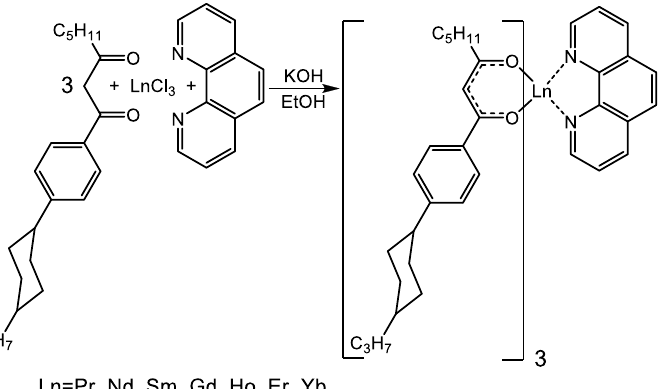
Figure 1. Synthesis of tris( β -diketonate) lanthanide(III) complexes with 1,10-phenanthroline. The solutions of these complexes in toluene (1 × 10 –3 mol/L) were used to fabricate films with the thickness of 100 ± 5 nm by spin coating [51]. We characterized optical properties of both solutions and films that contained La(III) complexes. The maximums of the UV/VIS absorption spectra obtained for the Ln(III) complexes dissolved in hexane (c = 1 × 10 − 5 mol/L, Figure 2a) are similar to the maximums observed for the individual ligands. Due to their structural features, these complexes allow production of homogeneous films by the spin coating deposition from their solutions. These films are transparent in the visible and near-infrared ranges (light transmission up to 99%) (Figure 2b).